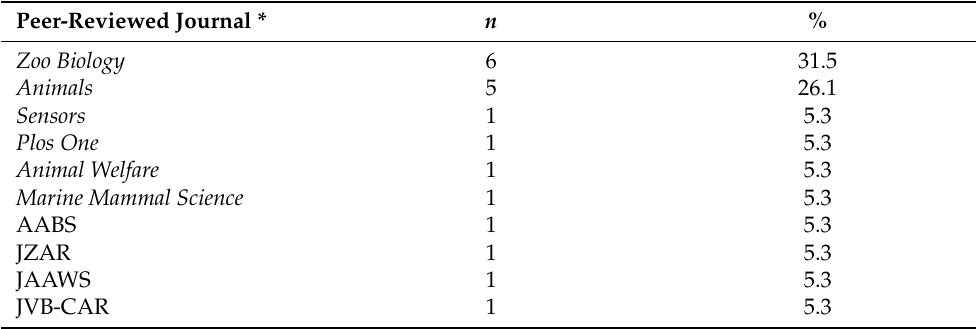
Table 3. Number and percentage of publications by peer-reviewed journal.